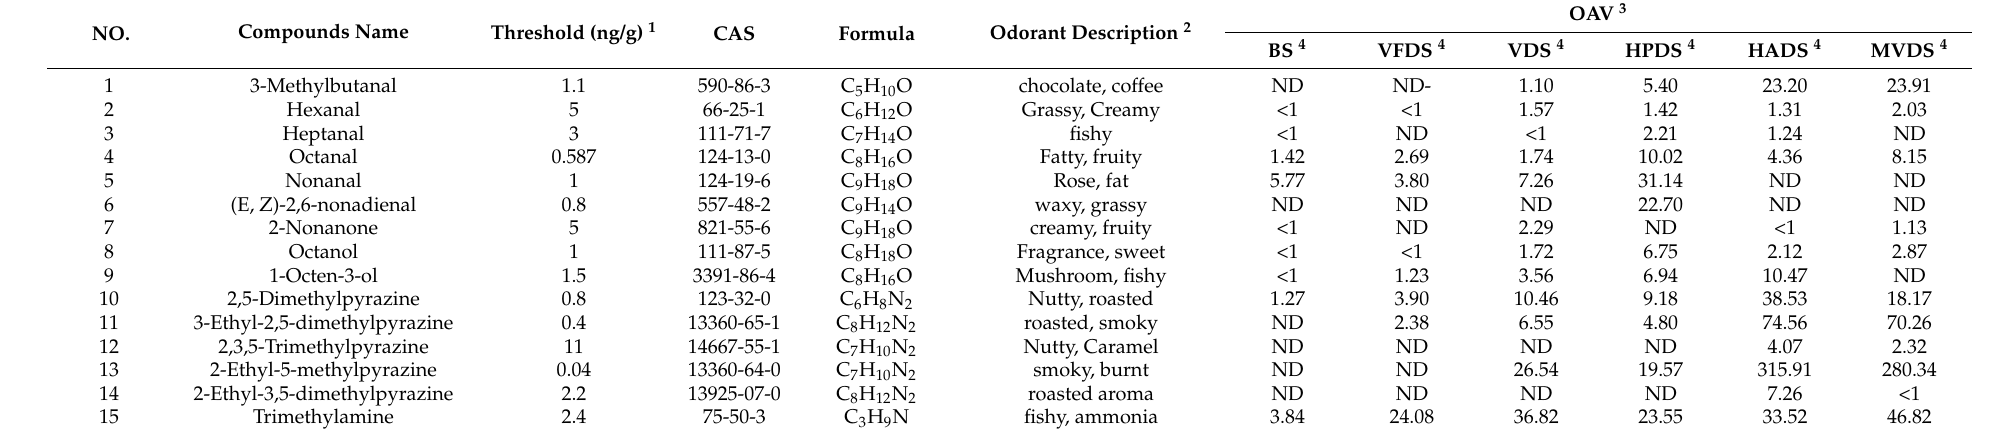
Table 2. Comparison of AACS content in different dried shrimp